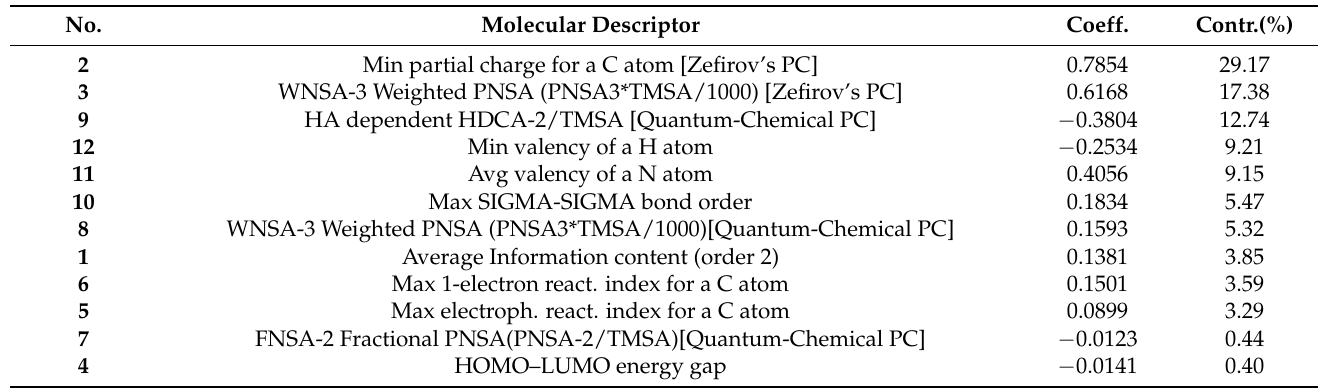
Table 2. Regression coefficients and the contribution of each molecular descriptor in the final